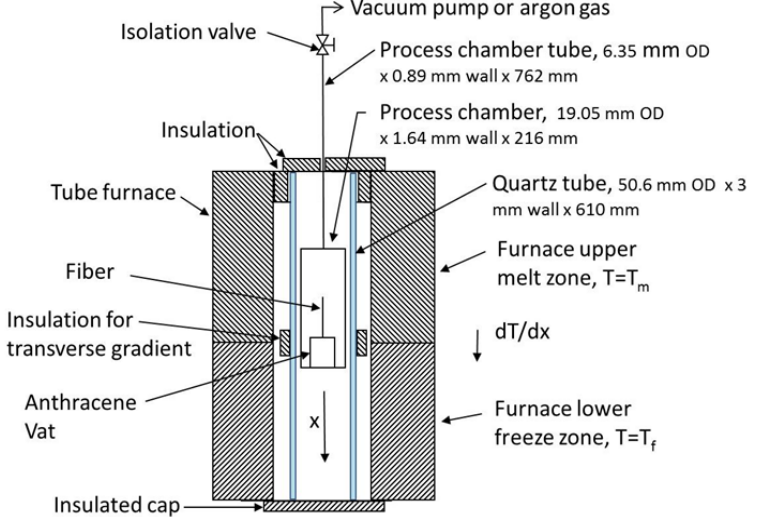
Figure 1. A schematic diagram of the furnace and chamber cross section of the vertical Bridgman-Stockbarger technique for growing single anthracene crystals inside microstructured